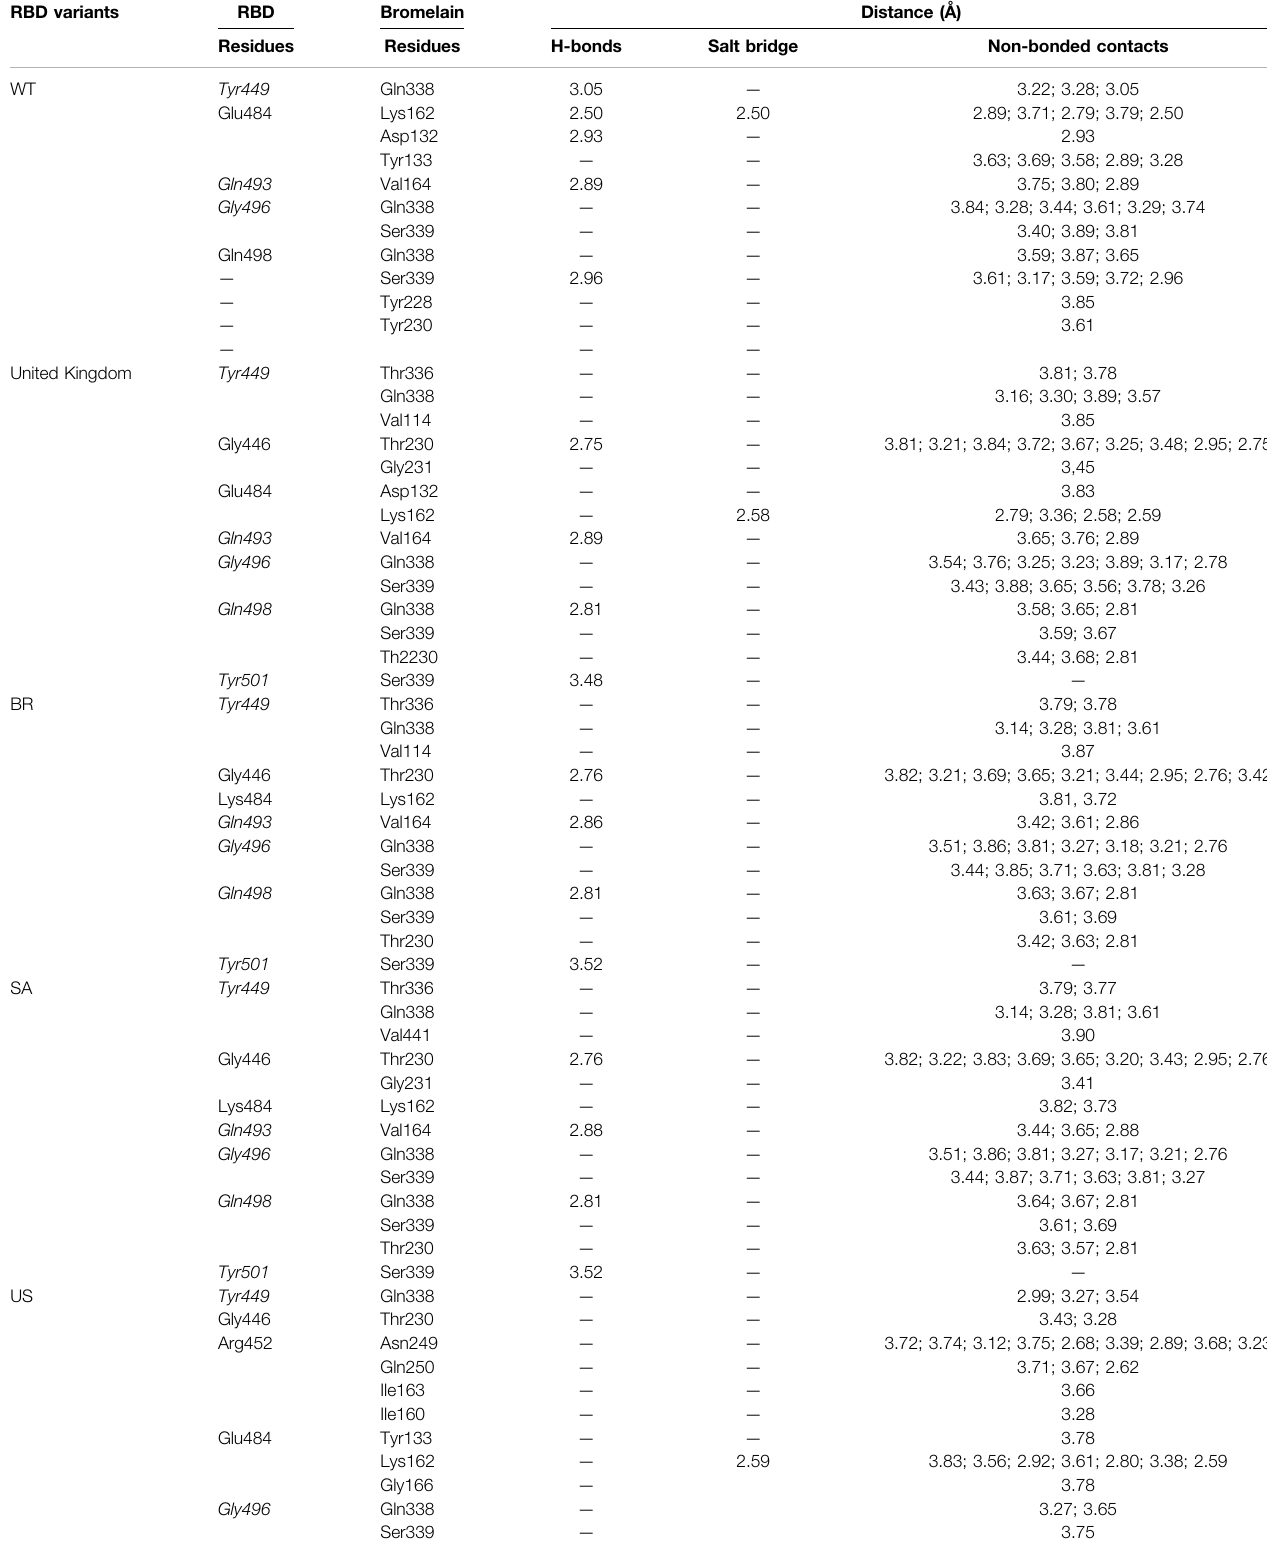
TABLE 2| The position of theinteracting residues of bromelain with RBDs pocket and mutation sites (highlighted in bold). Key amino acid residues thatplay arole in binding RBD to hACE2 are marked with an italic font. RBD